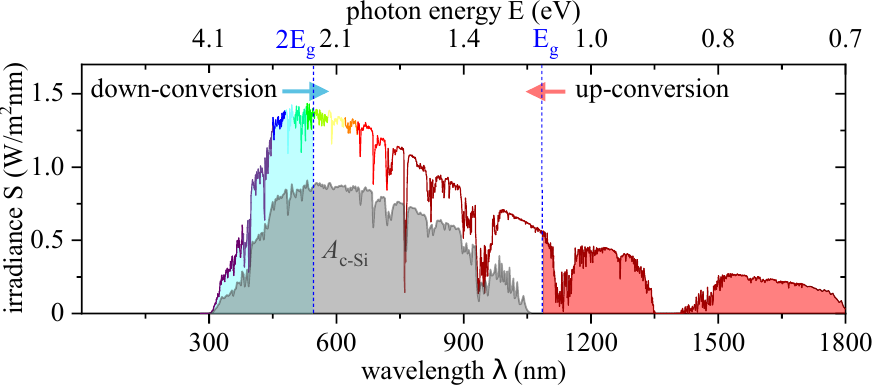
Figure 1. Solar irradiance S according to the global standard spectrum AM1.5g together with the solar power absorbed by undoped crystalline silicon A c − Si bulk material. The (indirect) band gap energy E g of silicon is highlighted together with the double band gap edge. Spectral converters allow re-emitting light toward the photo-active spectral region of a solar cell. The transfer of energy to higher (up-conversion) or lower (down-conversion) energies via multi-photon processes can boost absorption in the solar cells when re-emitting light closer to the Si band gap edge employing quantum dots, rare earths and other